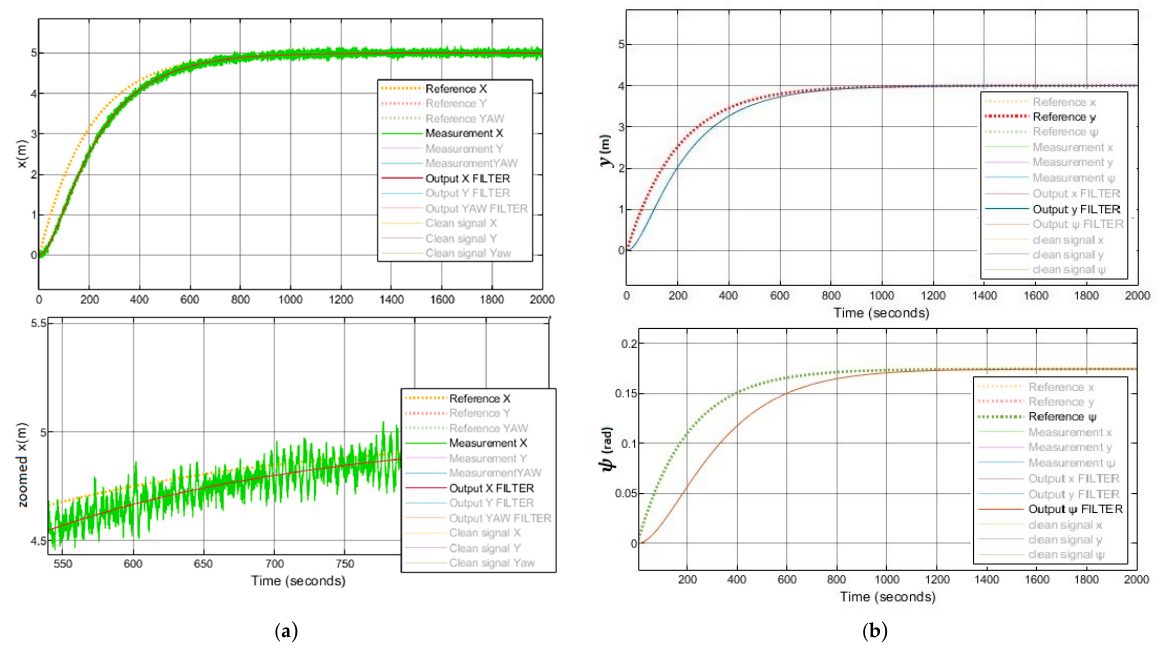
Figure 6. System with LQG controller control results with waves, positions (x,y).